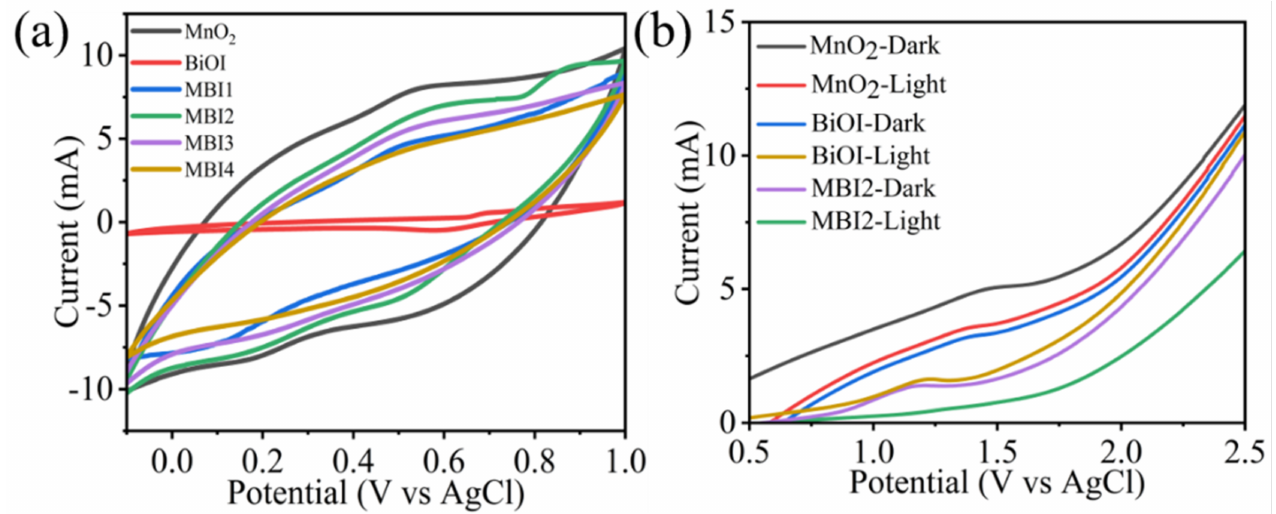
Figure 8. ( a ) CV and ( b ) LSV curve of pure α -MnO 2 , BiOI, and MBI